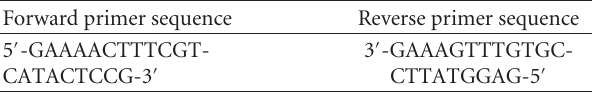
Table 2: IL8 ChIP primer covering bps − 177 to